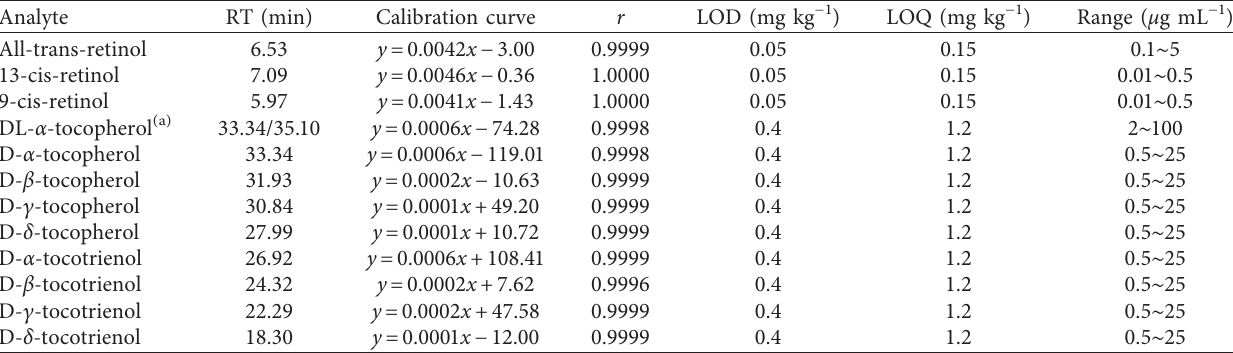
Table 1: Parameters of the RP-LC method for determination of vitamin E and retinol isomers. Analyte